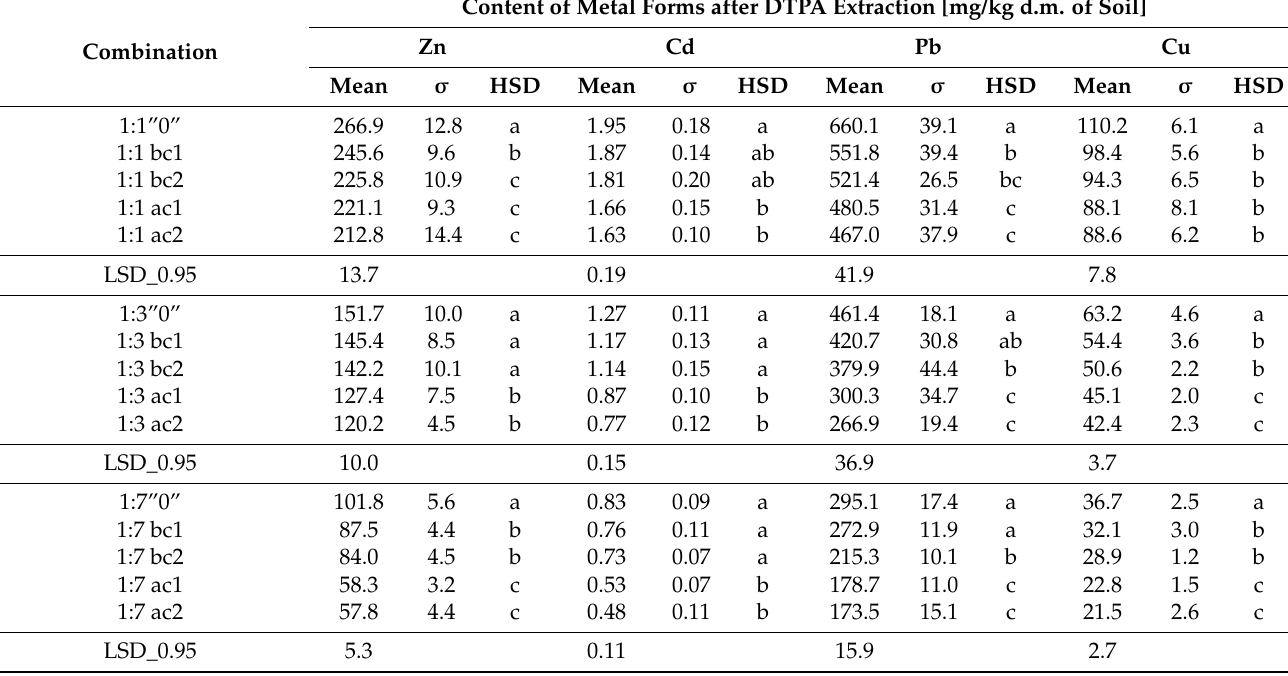
Table 5. Content of metal forms after DTPA extraction, depending on the dose of brown coal and activated carbon. Content of Metal Forms after DTPA Extraction [mg/kg d.m. of Combination